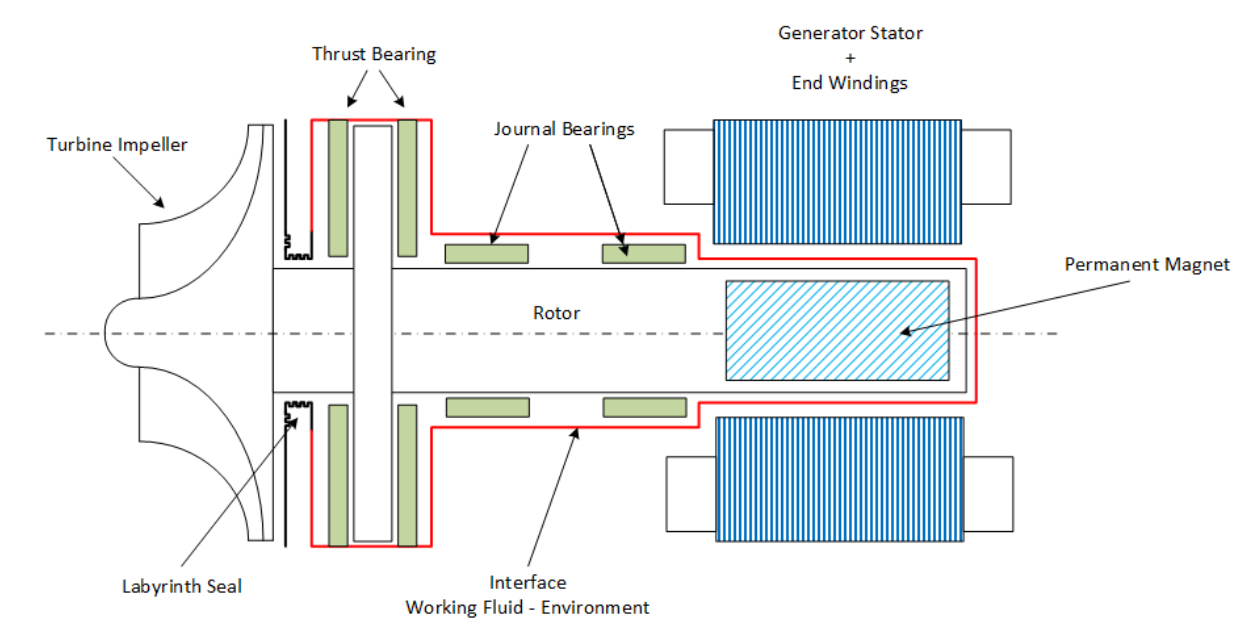
Figure 4. Schematic layout of a small-scale turbine using vapor as